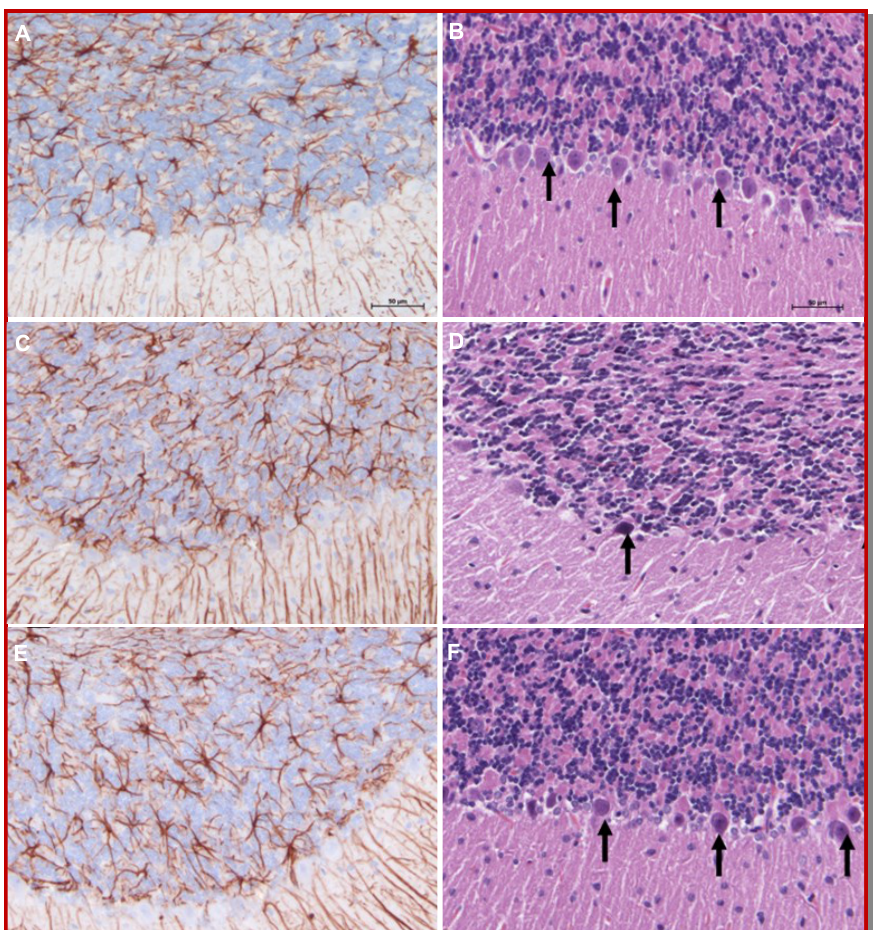
Figure 3: Microscopic view of glial fibrillar acidic protein (A-C-E) and H&E stained (B-D-F) cerebellum . Astrogliosis was charac- terized by glial fibrillar acidic protein immunostaining (Red- Brown staining). Normal control group male rat’s cerebellum and normal Purkinje cells (arrows) (A-B); propionic acid and saline group male rats have increased astroglial activity in the cerebel- lum, and degenerative changes in Purkinje cells (arrows) (C-D); propionic acid and medroxyprogesterone group male rats have decreased astroglial activity in the cerebellum, and improved Purkinje cell morphology (arrows) in cerebellum (scale bars = 50 μ m)